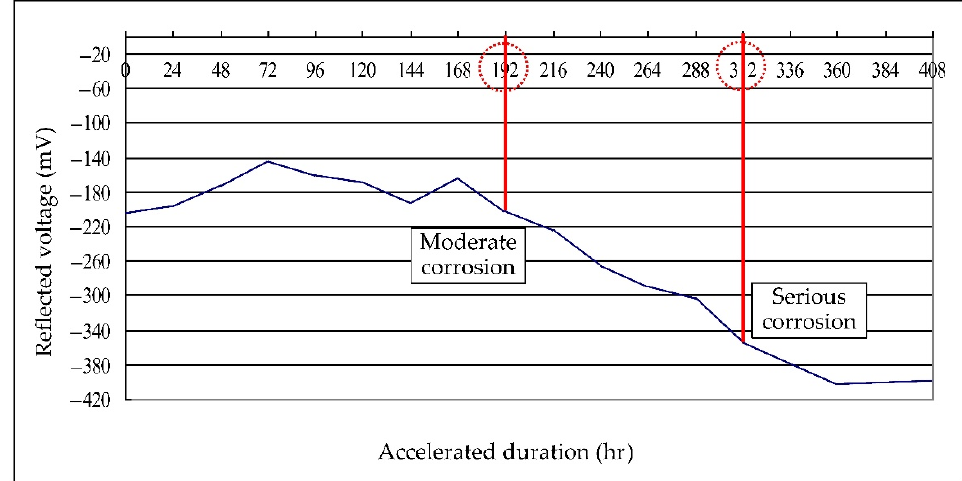
Figure 17. Corrosion Voltage for 4 cm Protective Layer.